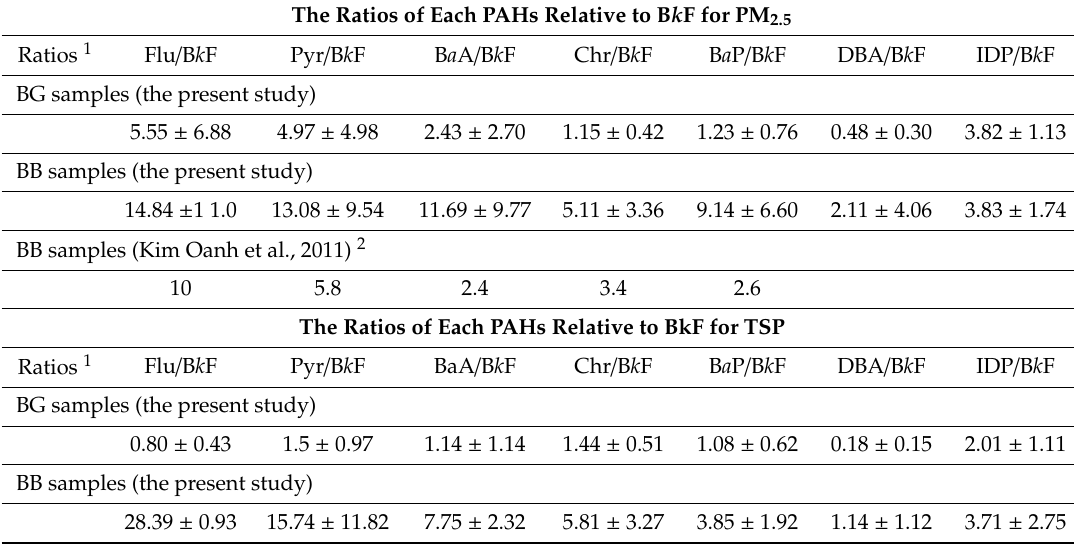
Table 3. Summary of PAHs profiles relative to B k F in PM 2.5 and